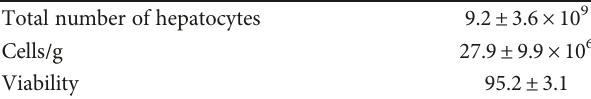
Table 1: Hepatocyte